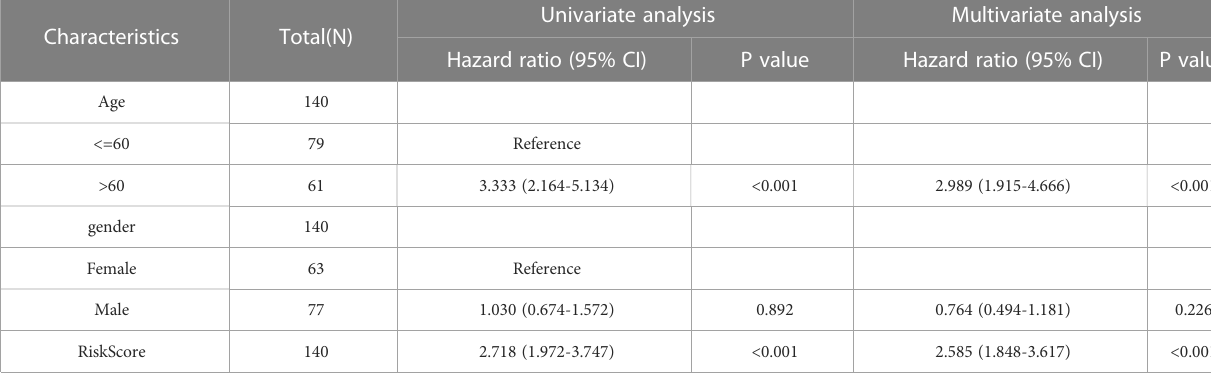
TABLE 3 Cox regression to MMRGs prognosis model and identify clinical features associated with OS in TCGA-LAML.